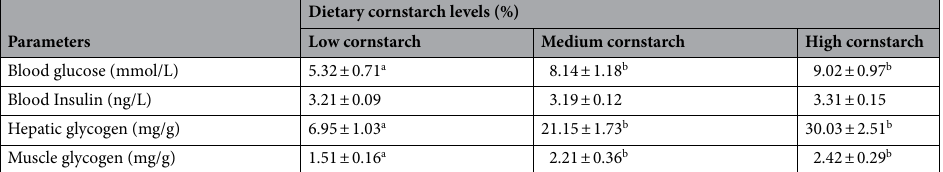
Table 4. Blood biochemical parameters in GIFT tilapia fed test diets*. *Data represented as mean ± SD of four replicate tanks. Values in the same row with different superscripts are significantly different ( P < 0.05).